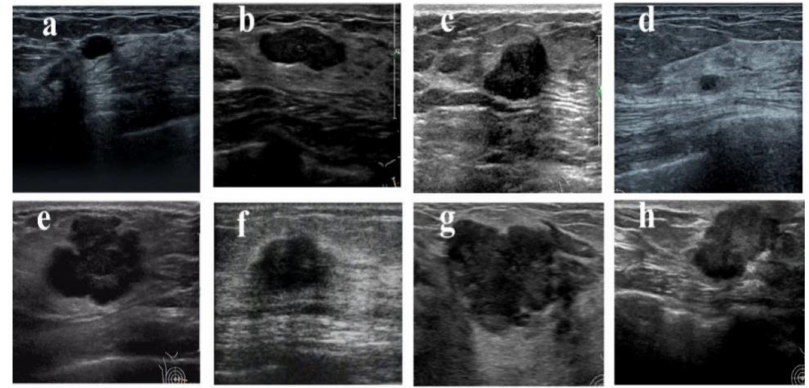
Figure 5. Examples of breast ultrasound images in our datasets. ( a – d ) are benign, ( e – h ) are malignant.